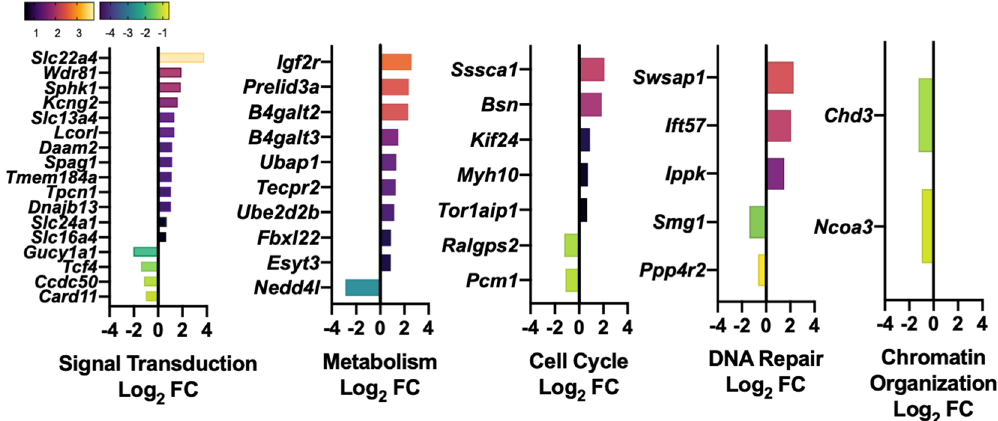
Figure 3. Post-simulated spaceflight revealed Reactome pathways involved in signal transduction, metabolism, cell cycle, chromatin organization, and DNA repair. Abridged Reactome pathway analyses of enriched DEG. Bar graphs of significant up (yellow) and down (purple) DEG (Log 2 fold change, FC) ( p > 0.05). Reactome pathways include, signal transduction, metabolism, cell cycle, DNA repair, and chromatin organization. Data represents n = 6 per group.